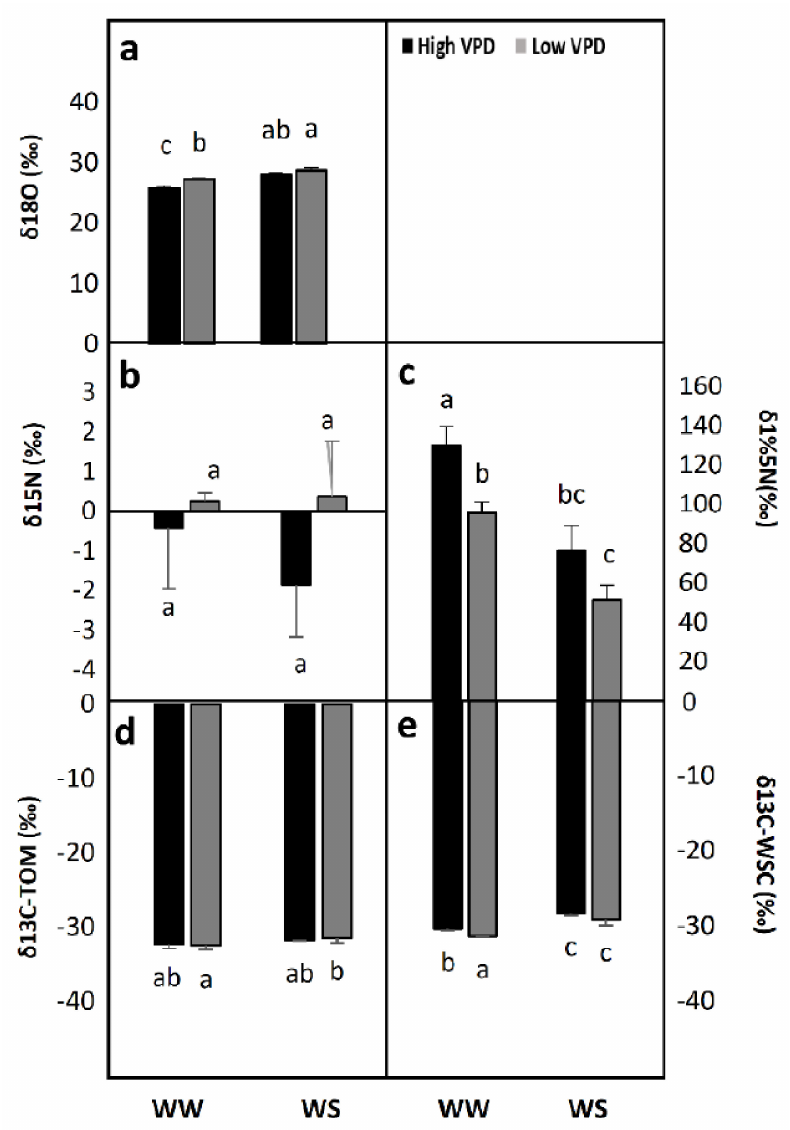
Figure 3. Effect of water irrigation (pot capacity-WW- versus 50% of pot capacity-WS) and ambient vapour pressure deficit (VPD; high 40 % RH versus low 80% RH) on ( a ) 18O isotopic composition ( δ 18O), 15N isotopic composition ( δ 15N) of ( b ) non labelled and ( c ) 15N labelled plants, 13C isotopic composition ( δ 13C) in ( d ) total organic matter (TOM) and ( e ) in water soluble content (WSC) deter- mined on wheat flag leaves. Each value represents the mean ± se of four replications. Statistical analysis was made by a two-factor ANOVA. Different letters above the columns indicate significant differences ( p < 0.05) between treatments as determined by LSD